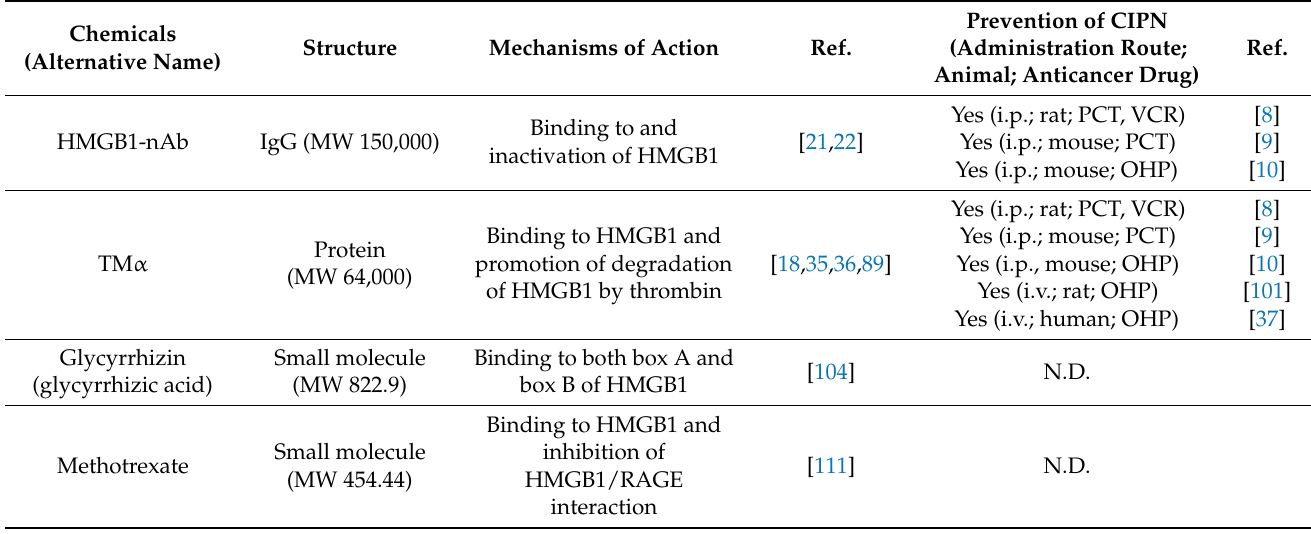
Table 1. Drug candidates targeting HMGB1 or its upstream/downstream molecules for prevention of